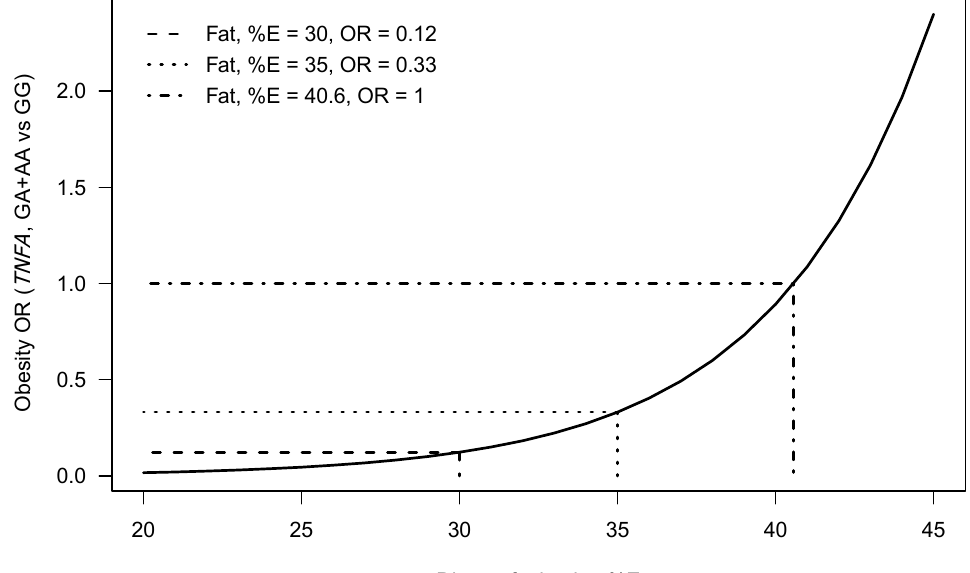
Figure 2. The modeled relationship between the odds of being obese (odds of being obese vs. being normal weight), TNFA –308 genotype and dietary fat intake (%E) for black SA women. The curve gives the modeled obesity OR for genotype GA + AA versus genotype GG, at each fat intake (%E). Lines show the total dietary fat intake (%E) of equal odds (OR = 1, for the genotype groups), namely 40.6 (%E), the OR for fat intake = 30 (%E) namely 0.12 and the OR for fat intake = 35 (%E), namely 0.33